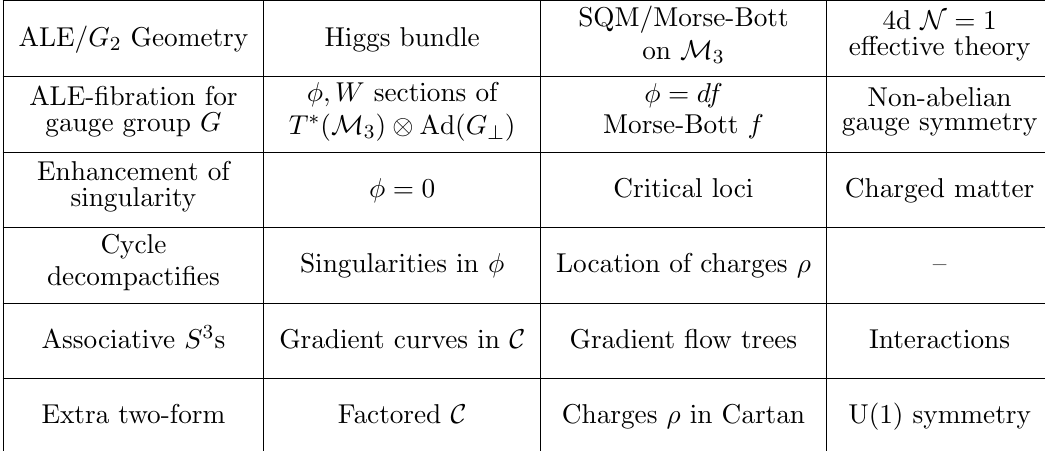
Table 1 . Dictionary between ALE-(cid:12)bration/ G 2 geometric data of the (cid:12)bration over M 3 , Higgs bun- dle, Morse-Bott theory on M 3 (alternatively SQM), and the 4d N = 1 low energy e(cid:11)ective theory.